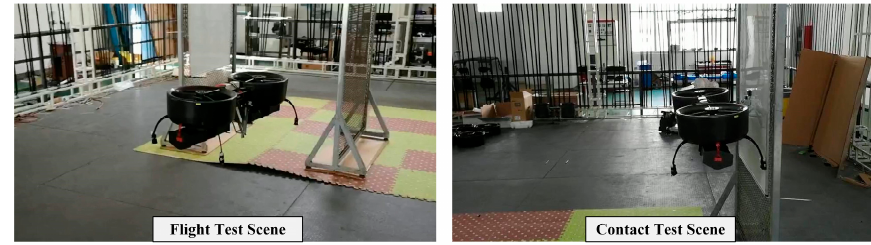
Figure 10. The scenes of the experimental